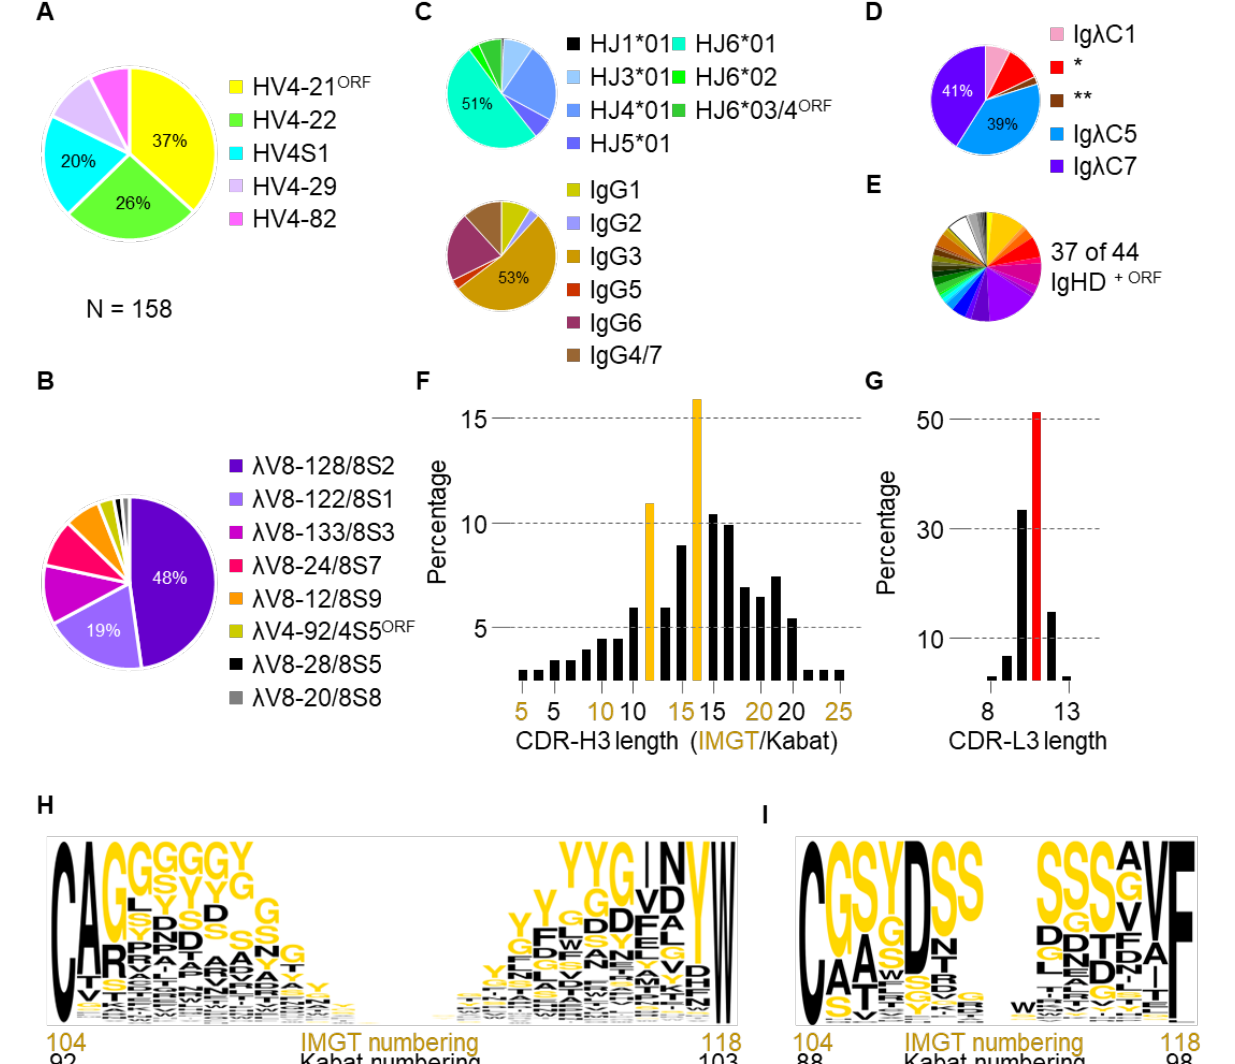
Figure 2. V -gene analysis of single sorted B cells. ( A ) Pie chart summary of the IgHV genes used by 158 single sorted B cells. Slices are listed in order of proportion relative to total. ( B ) Pie chart summary of the Ig λ V genes paired with the same antibodies as A, listed in order of proportion relative to total. ( C ) Summaries of IgHJ genes (top) and IgHC genes used by the same antibodies in A, listed in order of gene number. ( D ) Summary of Ig λ C genes used by the same antibodies as A. Allelic variants of Ig λ C1 are indicated with the asterisks, and are shown in Supplementary Figure S1A. ( E ) Summary of IgHD gene usage predicted from the isolated antibody CDR-H3 mature sequences, listed in Supplementary Figure S1B. ( F ) Bar graph showing CDR-H3 length distribution for the isolated sequences. The relative frequency in percentage is shown on the y -axis, while CDR-H3 lengths are reported on the x -axis. Both IMGT ® (gold) and Kabat (black) length reporting is shown. The bimodal peaks in length distribution are indicated with the gold bars. ( G ) Bar graph showing CDR-L3 length distribution, labelled as in F. The peak distribution at more than half of total sequences is indicated with the red bar. ( H ) A CDR-H3 logogram showing the amino acid composition at each position. White spaces represent decreasing representation with increasing CDR-H3 length. Predominant amino acids G, S, and Y are coloured gold. ( I ) Logogram of CDR-L3 amino composition, coloured and labelled as in H.